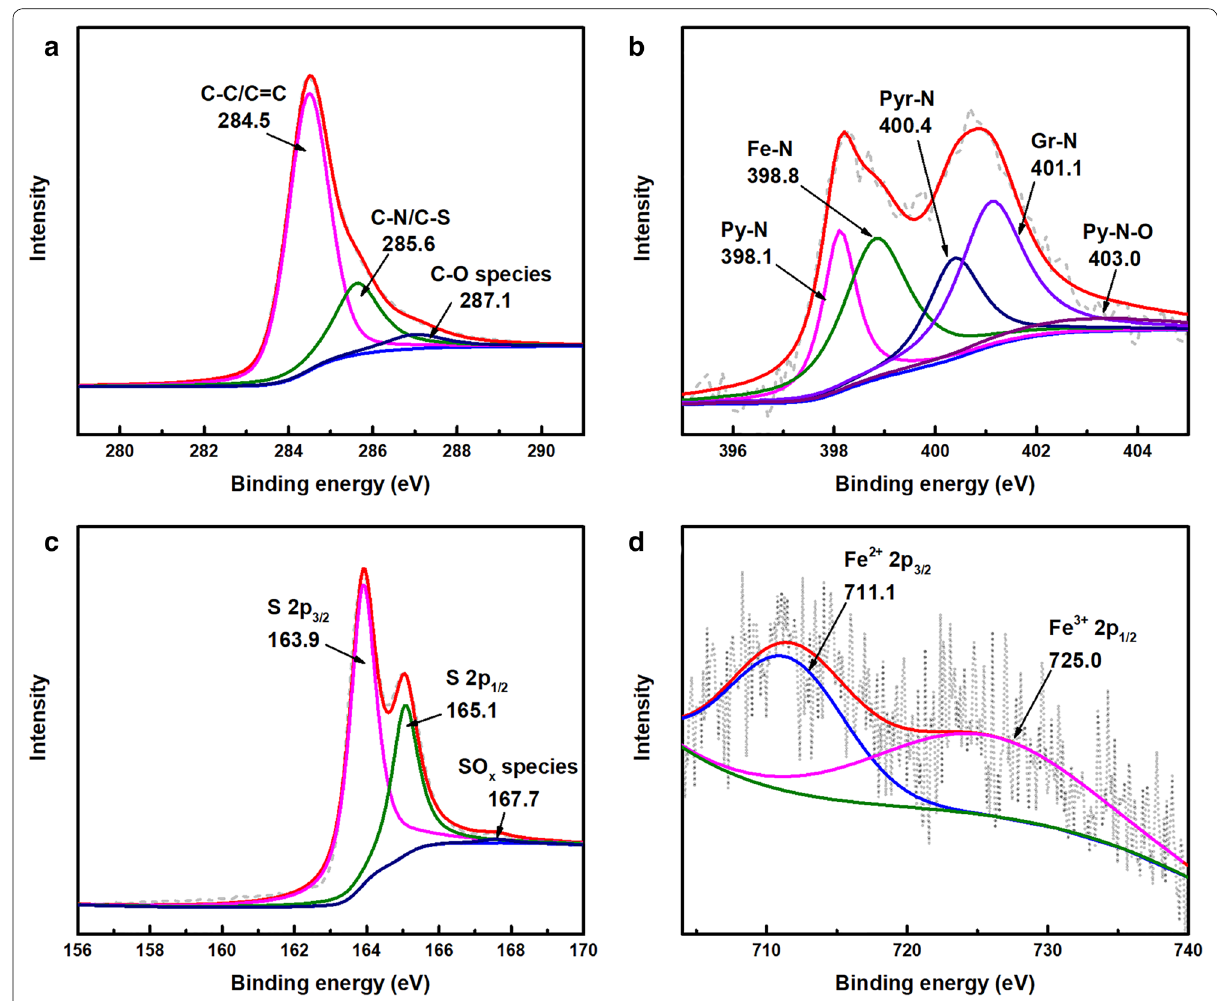
Fig. 3 High-resolution a C 1s, b N 1s, c S 2p and d Fe 2p XPS spectra of